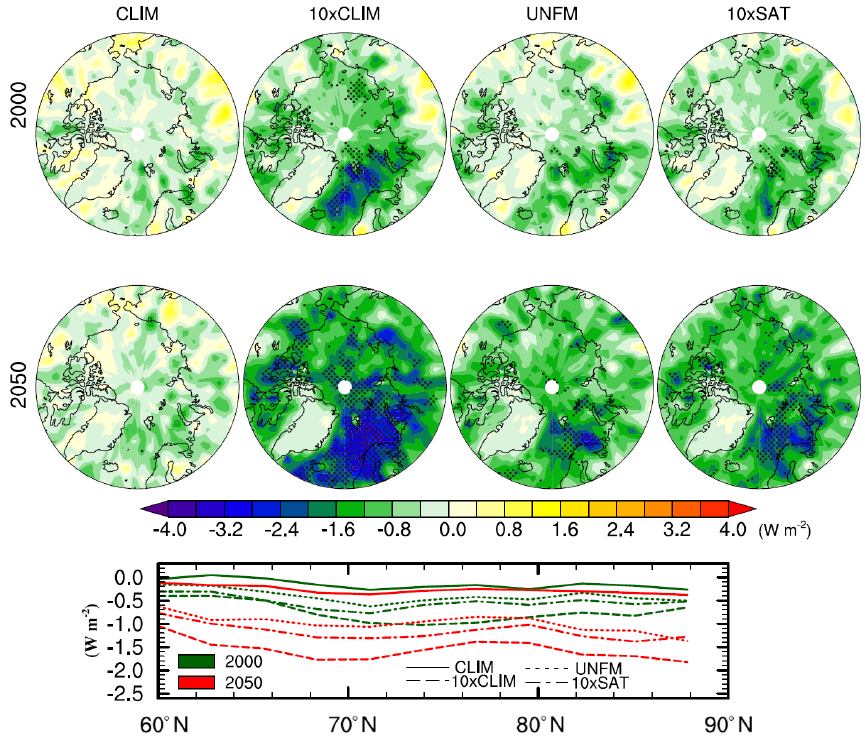
Figure 7. Cloud radiative forcing in the Arctic due to ocean DMS emissions. Stippling represents radiative forcing significant at the 95% confidence level. Zonal mean results are shown in the bottom